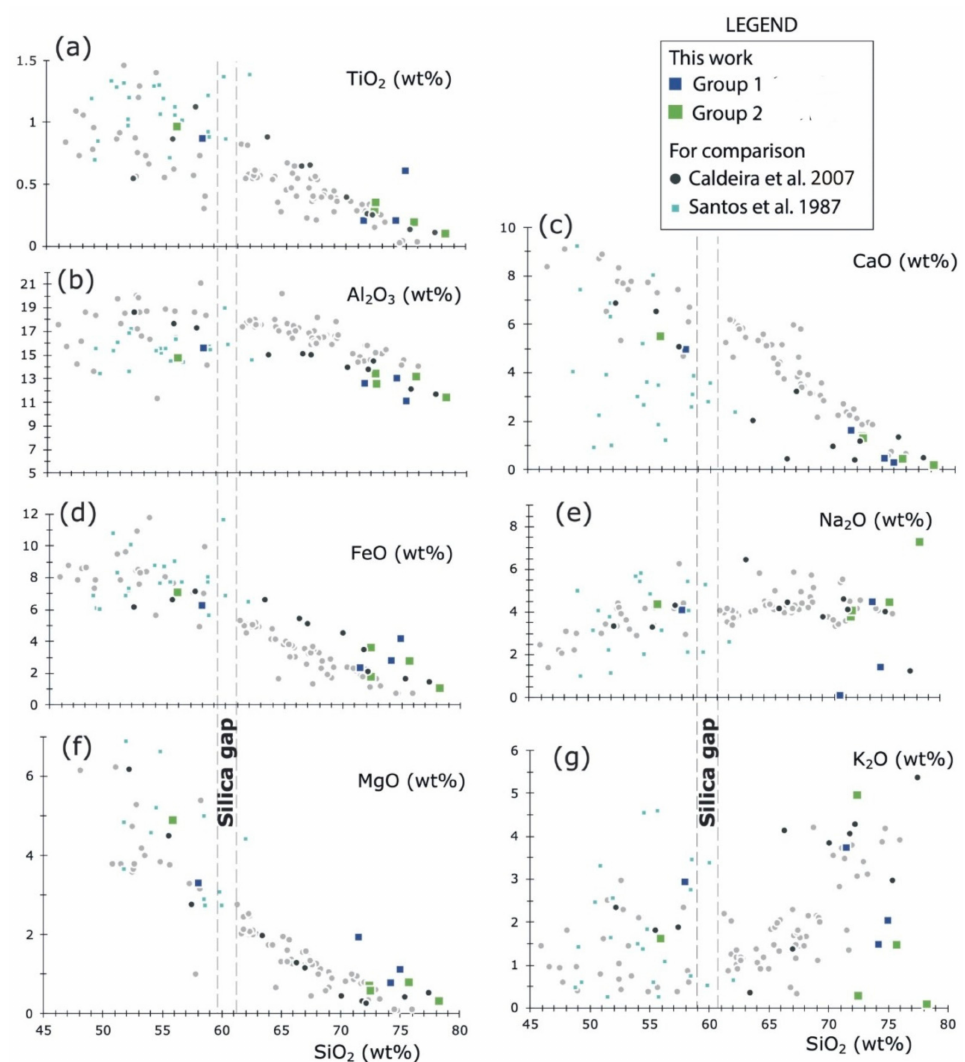
Figure 4. Harker diagrams for the Toca da Moura (Group 1) and Baleiz ã o-Alc á çovas (Group 2) 5b) in accordance with [51,52]. Groups 1 and 2 show similar abundances of fluid immobile igneous rocks showing the main geochemical variations on ( a ) TiO 2 , ( b ) Al 2 O 3 , ( c ) CaO, ( d ) FeO, elements such as Nb-Ta and Zr-Hf (Figure 5f,g). ( e ) Na 2 O, ( f ) MgO and ( g ) K 2 O contents. Grey dots are as in Figure 3.